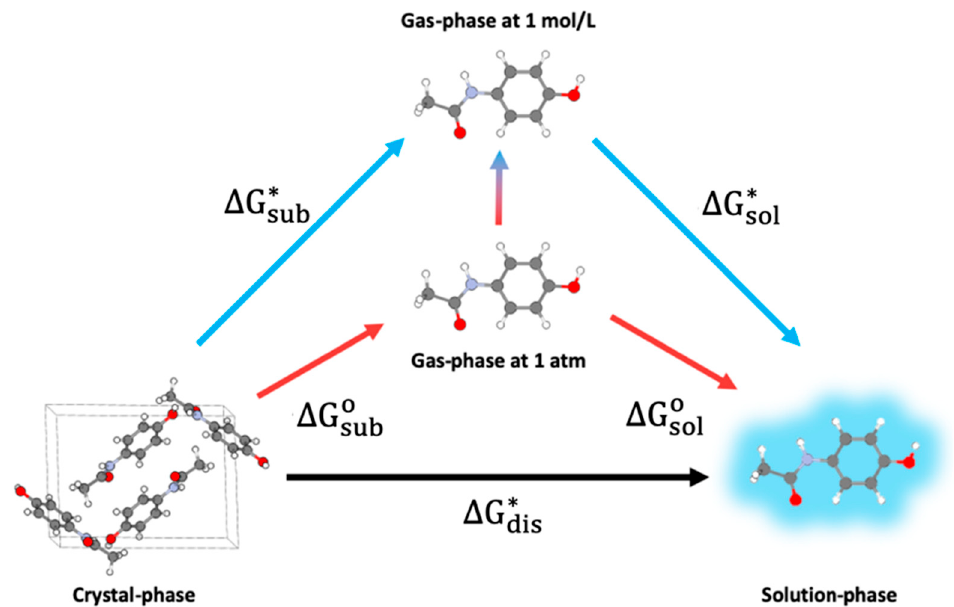
Figure 5. Thermodynamic cycle linking Gibbs free energy of dissolution of an organic molecule to its sublimation and solvation ‐ free energies. The linking requires a change in the standard state of the gas ‐ phase molecule (shown in the center).